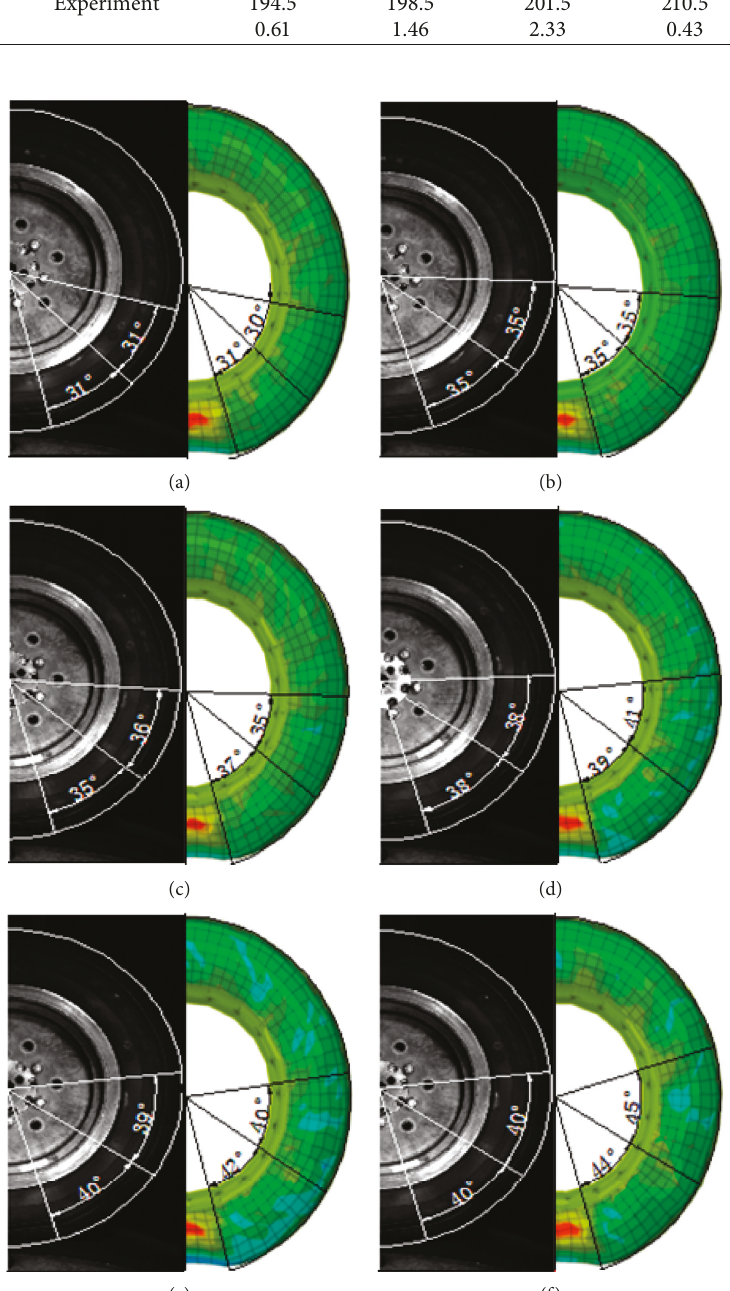
Figure 8: Comparison between experimental and simulated results on wavelength of standing waves within the π -arc at the rear of the ground-contact area at different velocities. (a) 180km/h. (b) 190km/h. (c) 200km/h. (d) 210km/h. (e) 220km/h. (f)